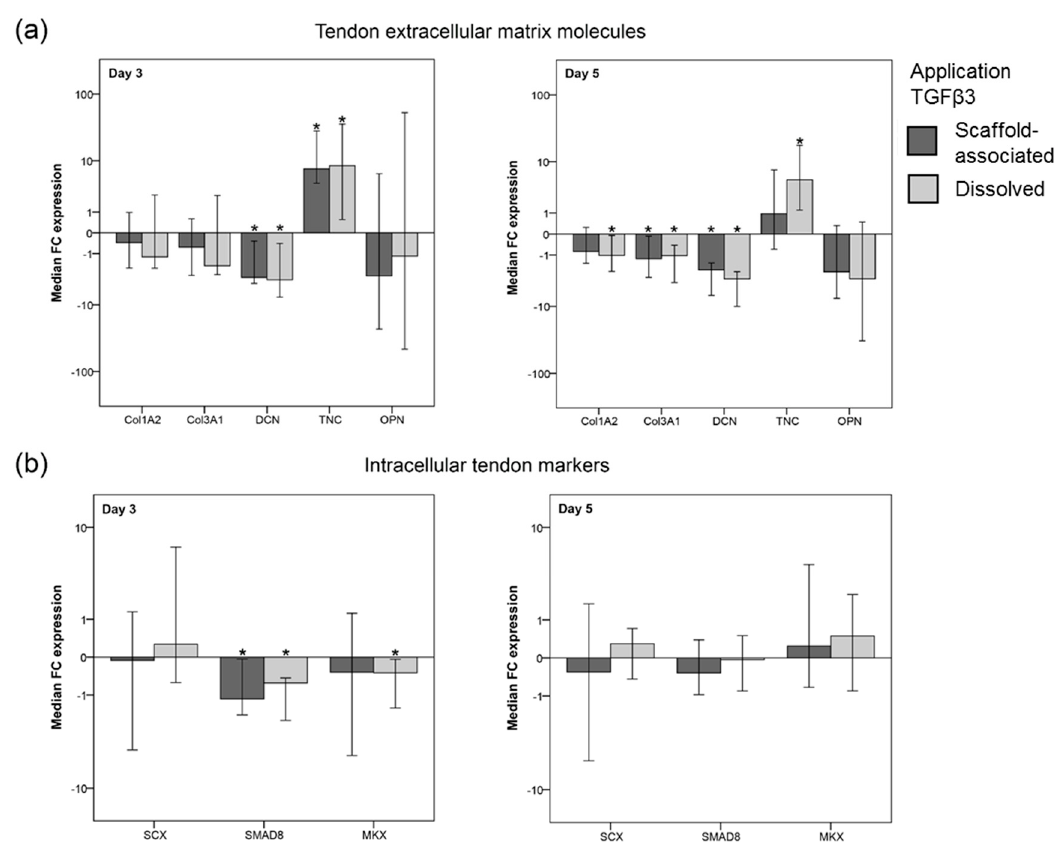
Figure 4. Gene expression levels of tendon extracellular matrix (ECM) molecules ( a ) and intracellular tendon markers ( b ) in tendon scaffold-seeded MSC. Data are given as “fold change” (FC) to the respective internal control (w/o TGF β 3), which is displayed as a horizontal line intersecting the x -axis at zero. Tendon scaffolds seeded with MSC were either directly loaded with TGF β 3 (scaffold-associated) or supplemented with TGF β 3 added to the cell culture medium (dissolved). Part ( a ) includes the gene expression of collagen 1A2 (Col1A2), collagen 3A1 (Col3A1), decorin (DCN), and tenascin c (TNC), as well as the expression of osteopontin (OPN), which is related to osteogenic differentiation. Part ( b ) shows the gene expression of scleraxis (SCX), smad8 (SMAD8), and mohawk (MKX). The total number of scaffolds within each group was 42 ( n = 42). Bars represent the median fold changes values and error bars the 95% confidence interval; * illustrates significant differences compared to the untreated control (w/o TGF β 3) ( p < 0.05).